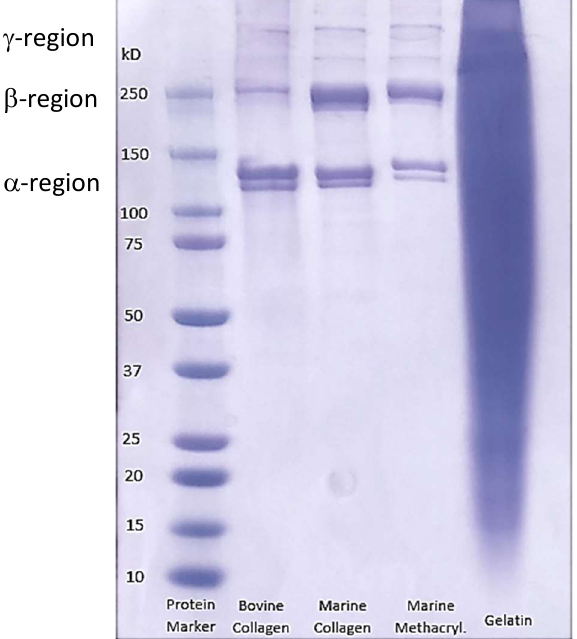
Figure 4. SDS-PAGE of commercially available bovine collagen and gelatin, compared with our extracted marine collagen, before and after methacyrylation.